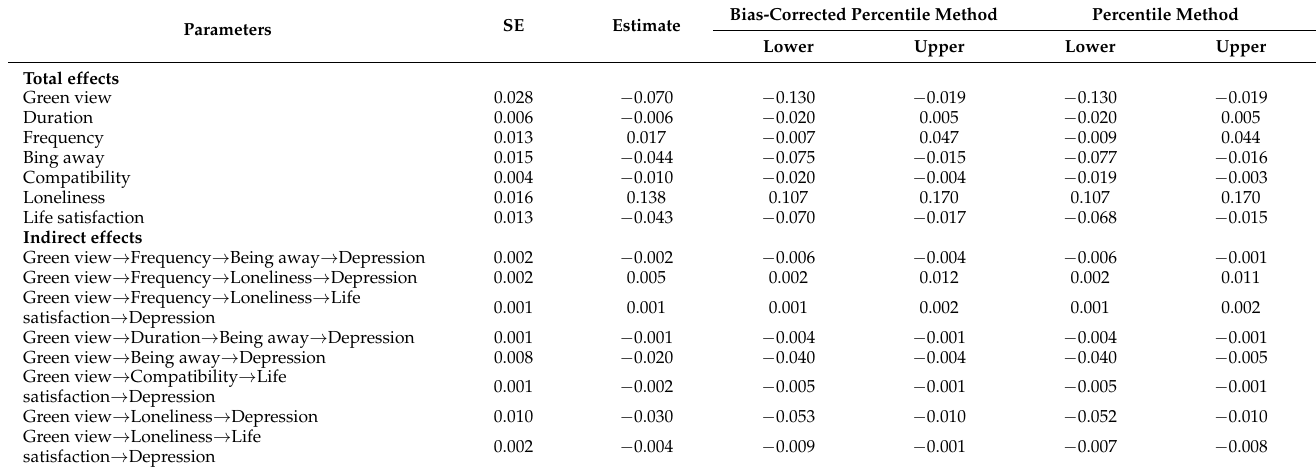
Table 4. Effects of green view and mediators on depression in the structural equation